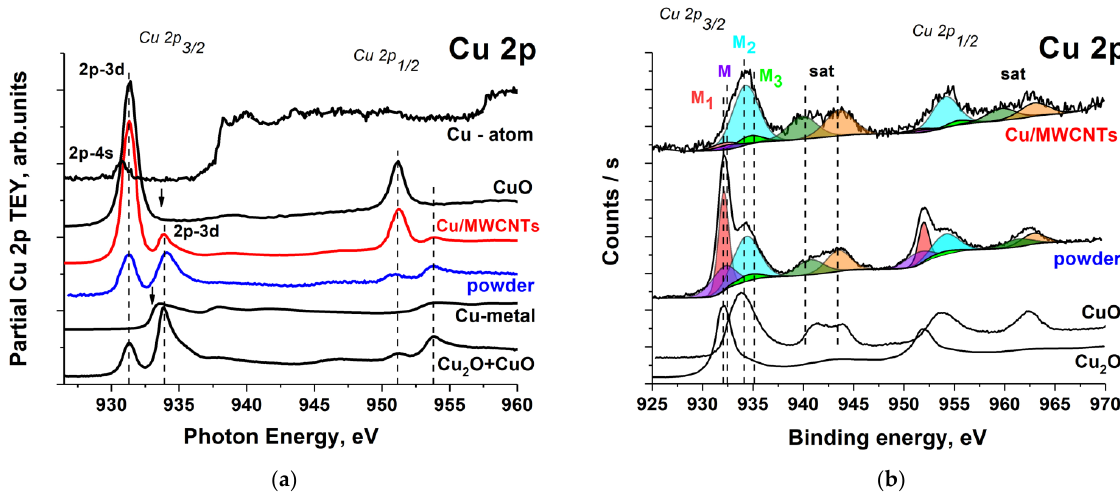
Figure 9. ( a ) comparison of the Cu 2p NEXAFS partial spectra of powder, Cu/MWCNTs hybrid nanocomposite, copper oxide CuO, cuprous oxide Cu 2 O with a low admixture of CuO, metallic copper, and photoion yield spectrum of atomic copper [55]. The arrows indicate the BE of the 2p 3/2 electrons [56] in metallic copper (932.6 eV) and copper oxide CuO (933.6 eV). ( b ) Cu 2p XPS spectra of powder, copper oxide CuO, Cu/MWCNTs hybrid nanocomposite, and cuprous oxide Cu 2 O [57]. All the spectra were normalized to the TEY signal at the photon energy of 960 eV. In free copper atoms with the [Ar] 3d 10 4s 1 electronic configuration, the 3d electron shell is completely filled, and, therefore, in the 2p absorption spectrum of free copper atoms, there is no structure corresponding to 2p electron transitions to 3d states, and only a low-intensity peak Cu 2p 3/2 → 4s at the photon energy of 931.17 eV is observed [55]. Copper atoms in the metal have the electronic configuration [Ar] 3d 10 − x 4s 1+x , x = 0.4 – 0.45 [58,59], indicating the hybridization of the 3d and 4s electronic states of the copper atom in the valence band of the metal. As a result, the unoccupied electronic states at the bot- tom of the conduction band of copper also have a hybridized character with 3d electron contributions. In the Cu 2p spectrum of metallic copper, these 3d electron contributions provide a noticeable intensity of absorption 2p electron transitions to low-energy unoc- cupied electron states. In particular, the first absorption band at a photon energy of 933.5 eV is associated with such transitions. The consideration of the spectra in Figure 9a reveals that the Cu 2p 3/2 NEXAFS spectra of the copper oxides are dominated by the intense absorption bands (CuO) and (Cu 2 O). The presence of a low-intensity peak at a photon energy of 931.3 eV in the Cu 2 O spectrum is related to the presence of the CuO admixture. The Cu 2p 3/2 electron BE of 932.18 eV in the Cu 2 O is close to the metal BE of 932.63 eV, and, in CuO, it shifts to the high energy region 933. 76 eV [56,57,60]. It should be noted that the absorption edge (the energy at half the first absorption band intensity) of the Cu 2 O sample is approximately in the same position as the one of pure Cu. However, the CuO absorption edge is shifted by about 2 eV in to the low energy region, and the first peak intensity increases more than